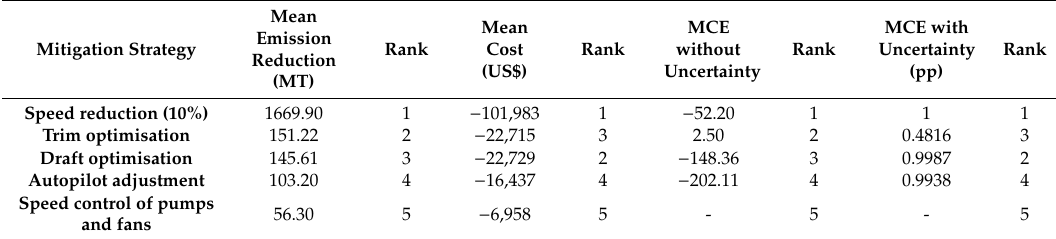
Table 6. Ranking of the mitigation strategies. MCE: marginal cost-e ff